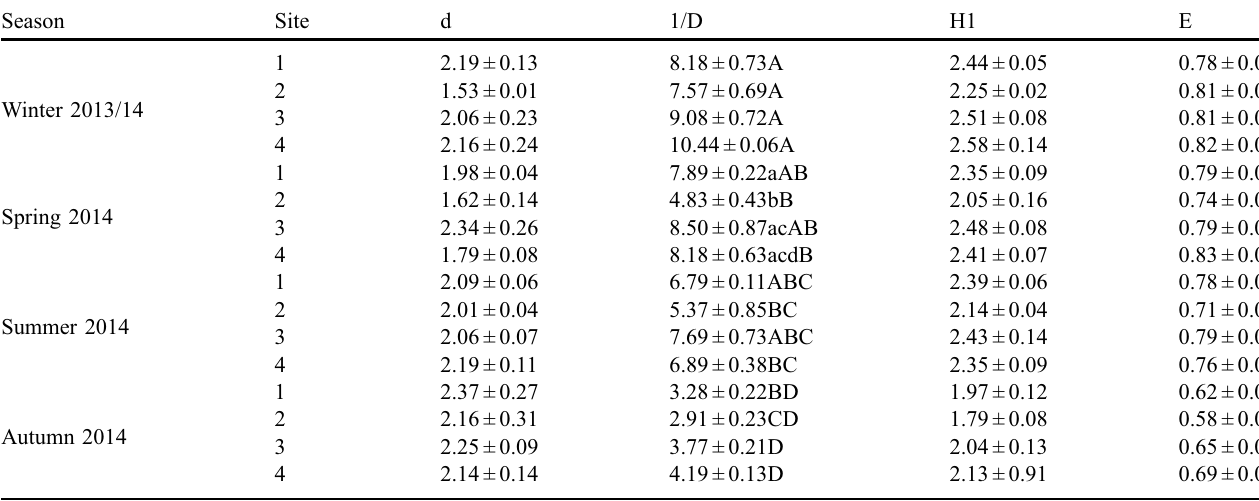
Table 2. Diversity indices measurement of phytoplankton in Lake Chamo during winter 2013/14 (season I), spring 2014 (season II), summer 2014 (season III), and autumn 2014 (season IV).